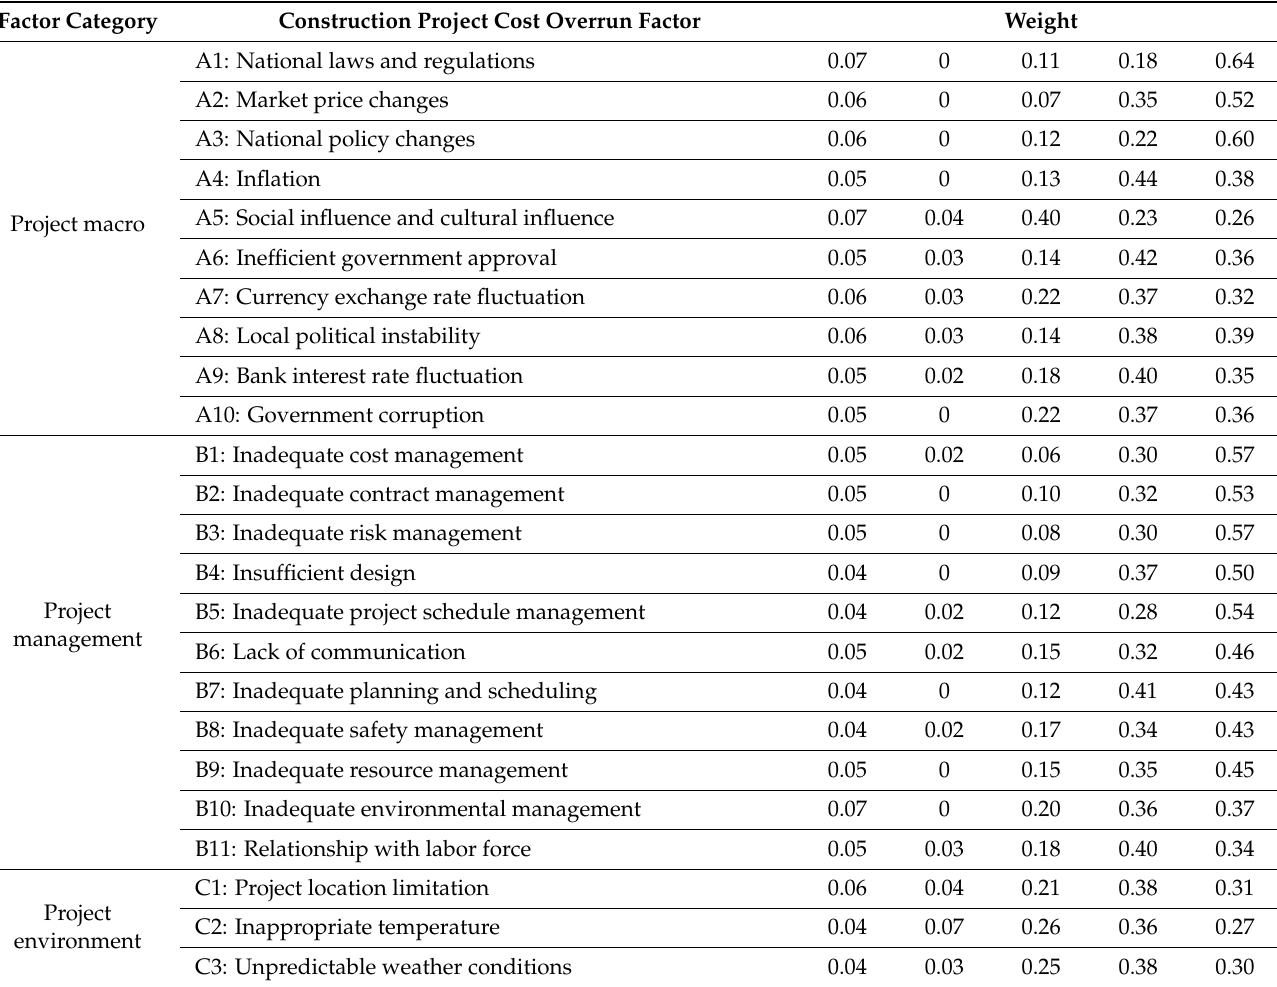
Table 5. Fuzzy relational matrix data indicators for cost overrun